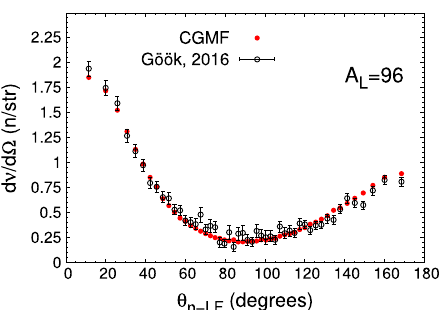
Fig. 6. Angular distribution of the prompt fi ssion neutrons vs. the light fragment direction in the thermal neutron-induced fi ssion of 235 U, for the pre-neutron emission light fragment mass A L = 96, as calculated using the CGMF Monte Carlo Hauser- Feshbach code [16] and compared to experimental data by Göök et al.